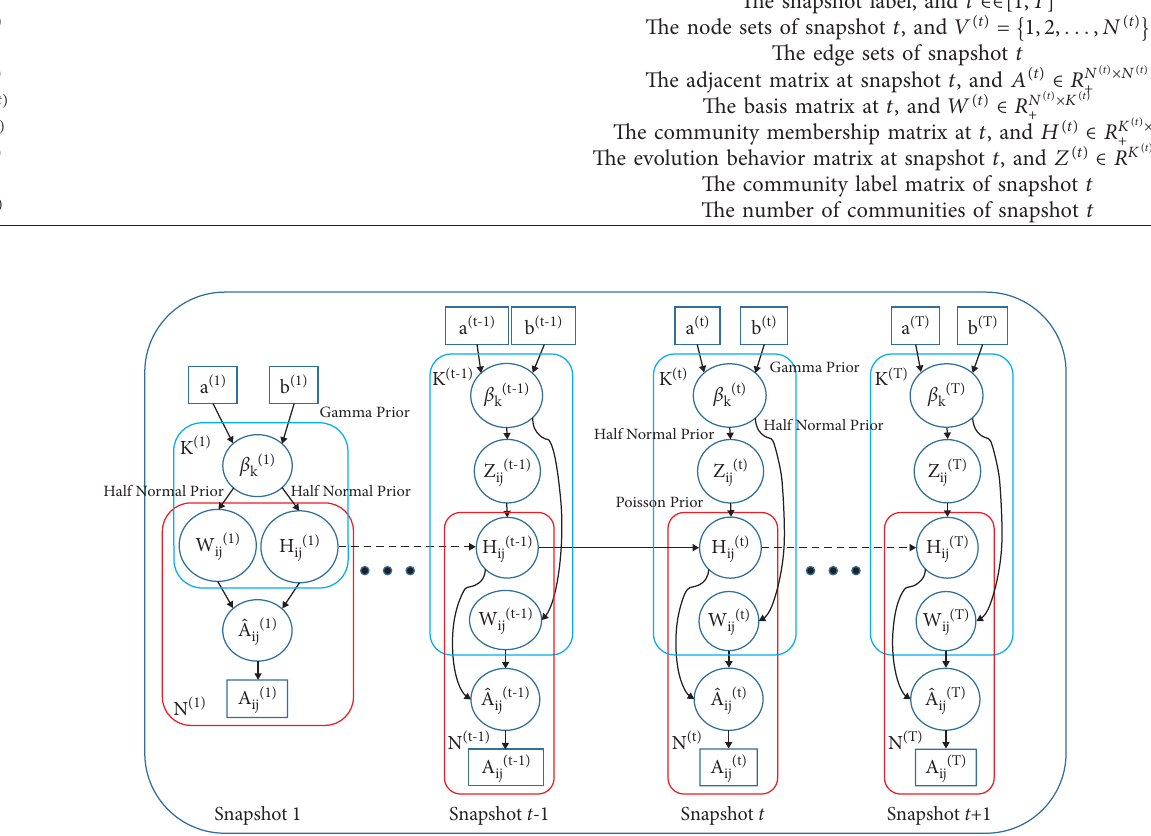
Figure 1: Graphical model of the proposed